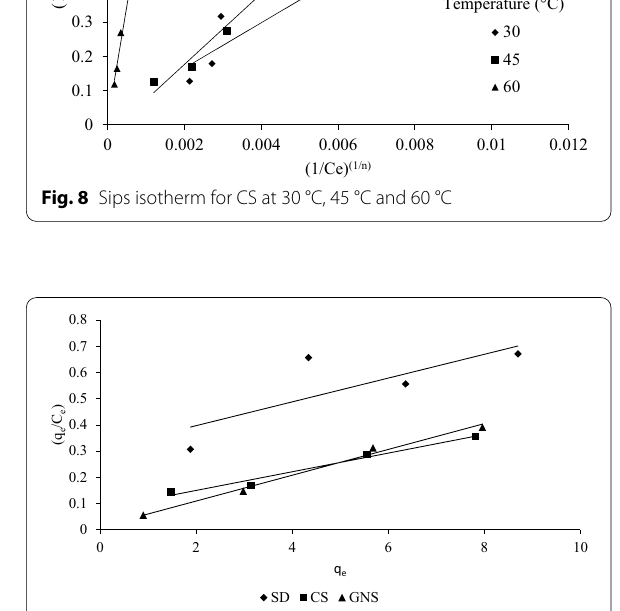
Fig. 9 ( q e / C e ) vs q e plot to obtain K c for sorption of MB on SD, CS and